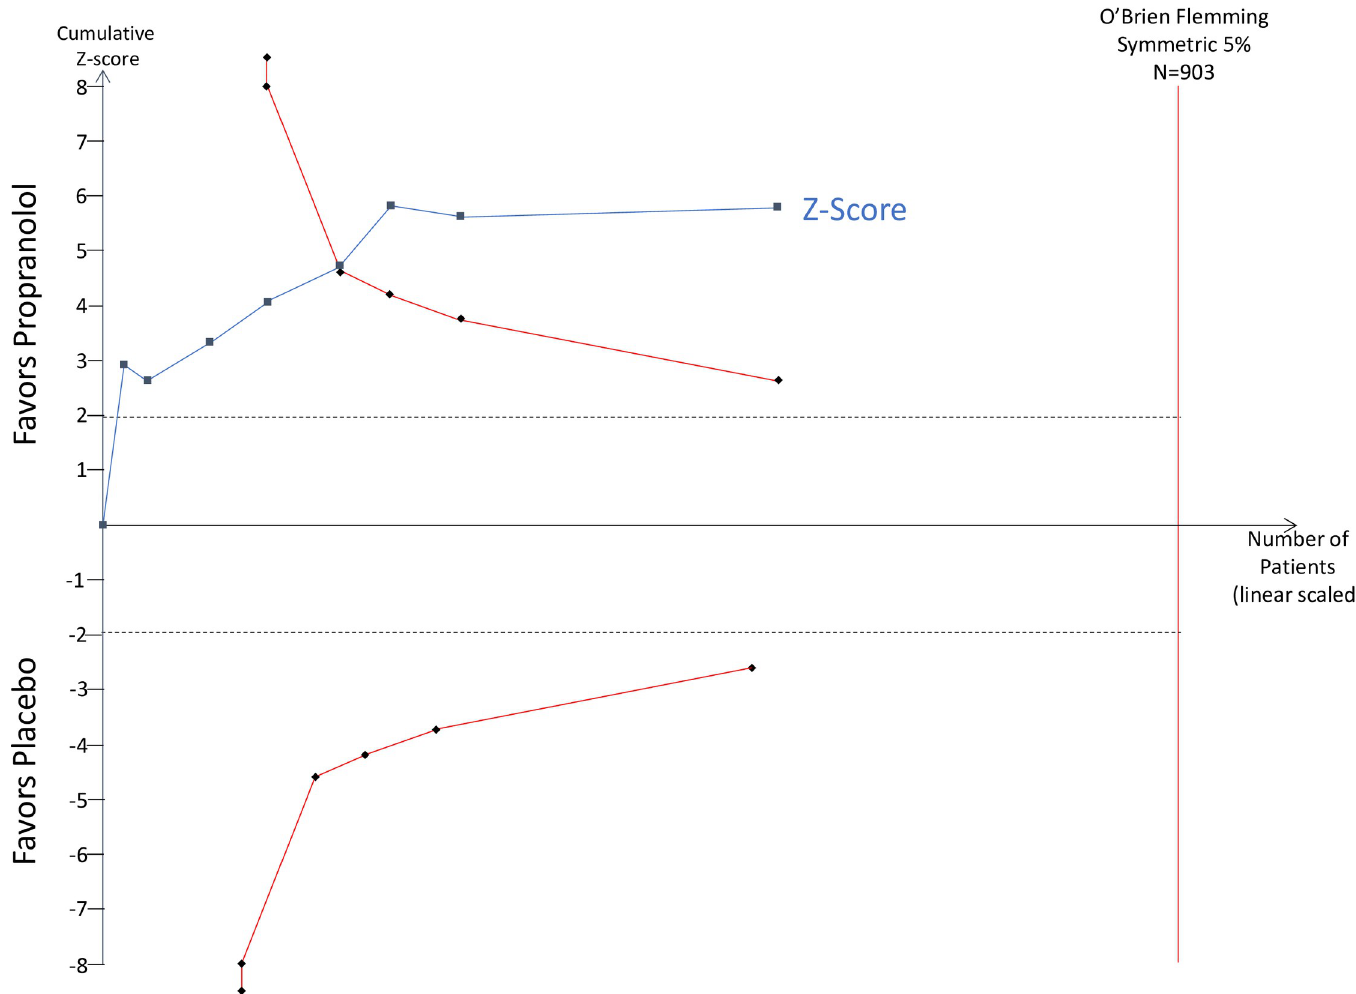
Fig 3. Trial Sequential Analysis (Propranolol v.